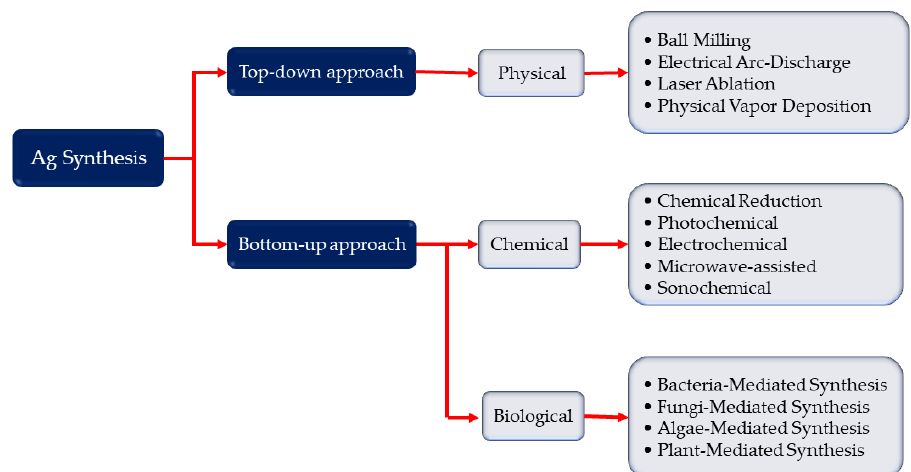
Figure 2. Synthesis of silver nanoparticles: top-down and bottom-up approaches, i.e., physical, chemical, and biological synthesis processes independently. The top-down technique refers to the creation of complex clusters and obtained nanoparticles from molecular components, whereas the bottom-up approach relates to the synthesis of metal nanoparticles from bulk materials.